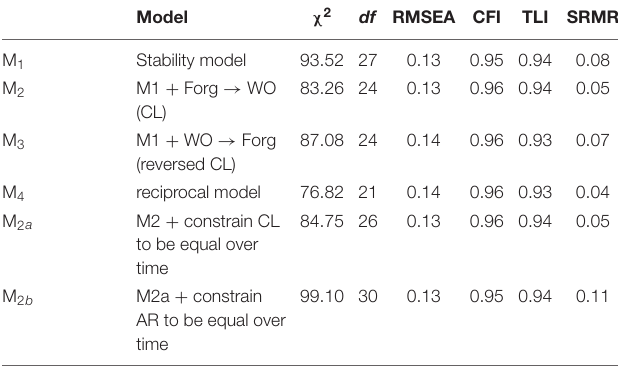
TABLE 3 | Fit indices for competing models.